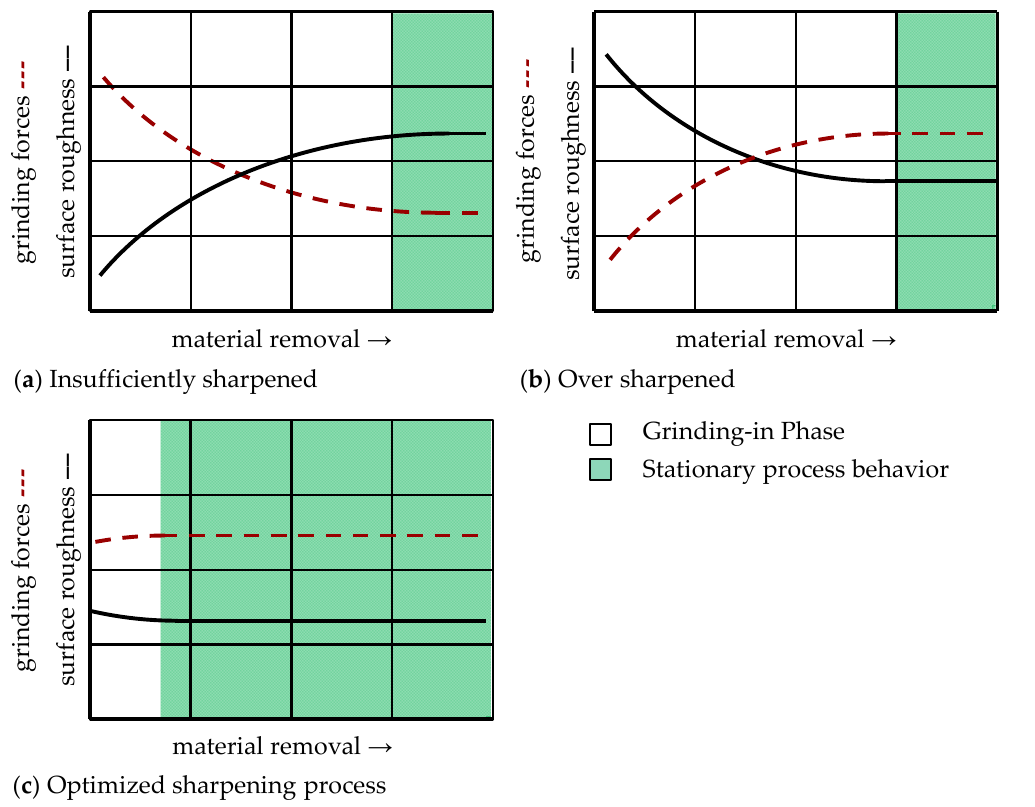
Figure 1. Grinding behavior of differently sharpened grinding wheels: ( a ) Insufficiently sharpened; ( b ) over sharpened; ( c ) optimized sharpening process [7].